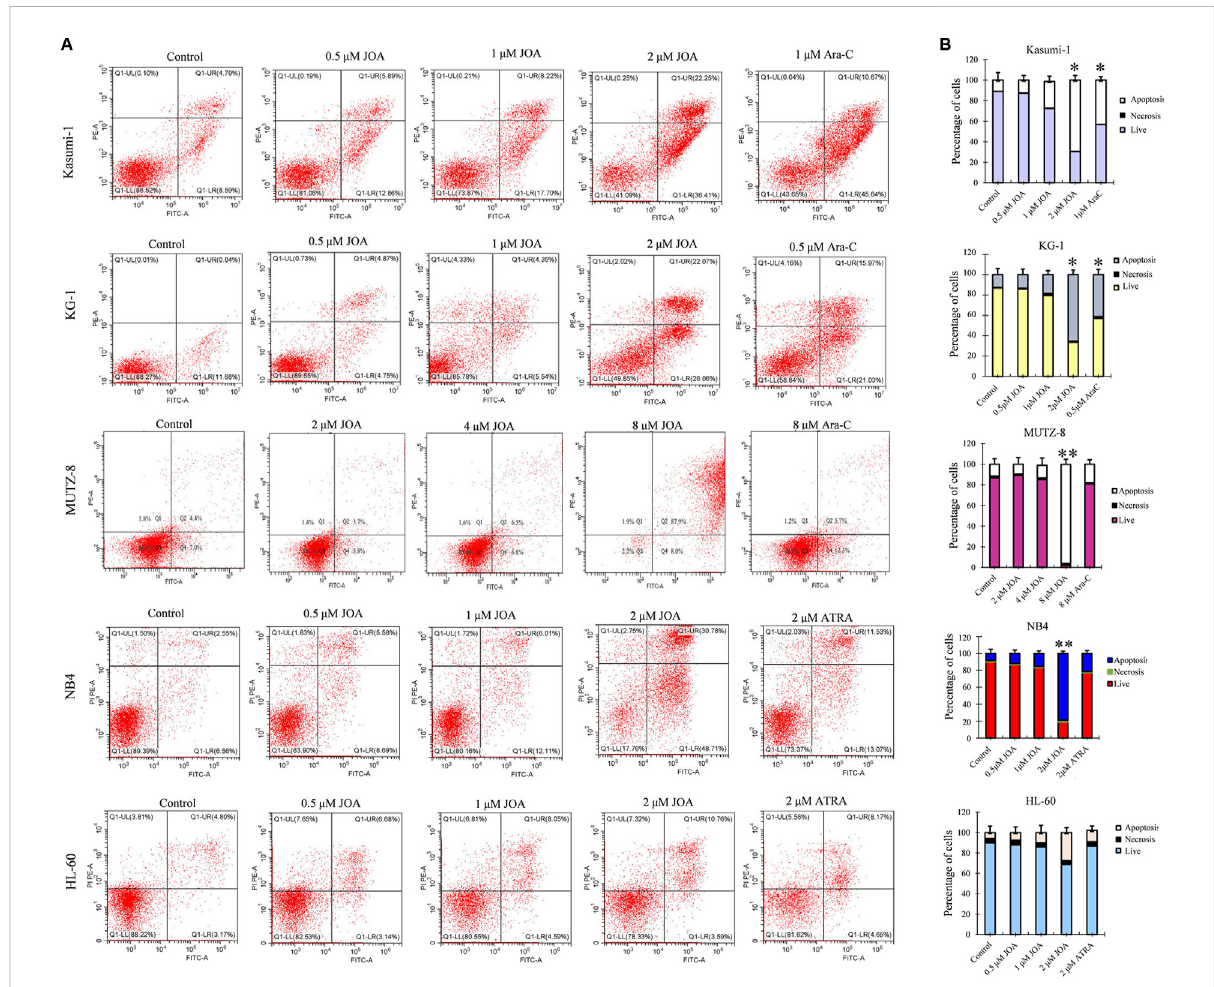
JOAinducedminimalsignsofapoptosisinKasumi-1,KG-1,MUTZ-8,NB4,andHL-60cells. (A) AnalysisofapoptoticcellsusingtheAnnexinV/PI apoptosis detection kit. (B) Percentages of apoptotic cells are presented as bar graphs (* p < 0.05 and ** p < 0.01). Cells were incubated with